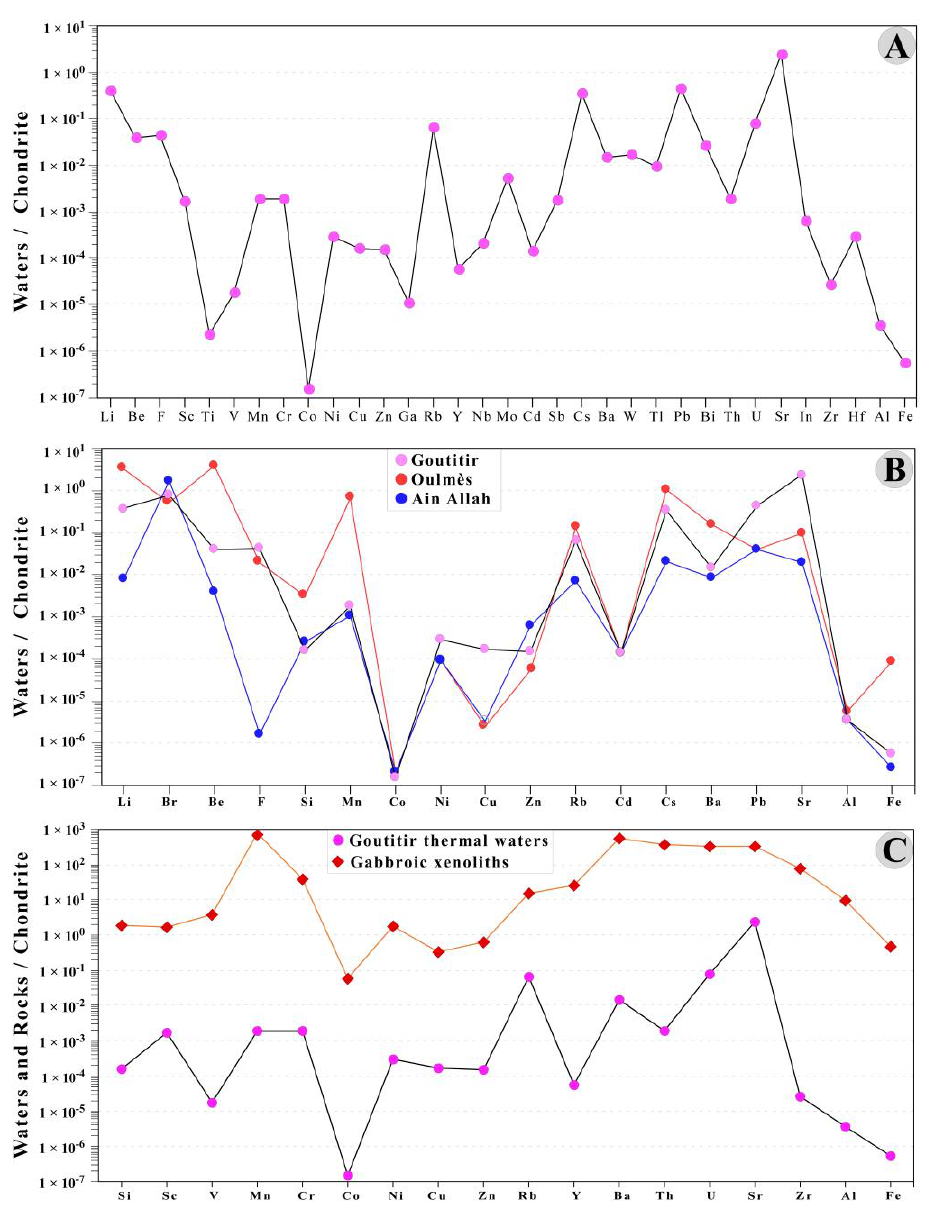
Figure 7. Chondrite-normalized trace elements patterns for the Goutitir thermal waters ( A ); Goutitir, Oulmès, Ain Alah thermal waters ( B ); and Goutitir thermal waters and Gabbro ( C ).